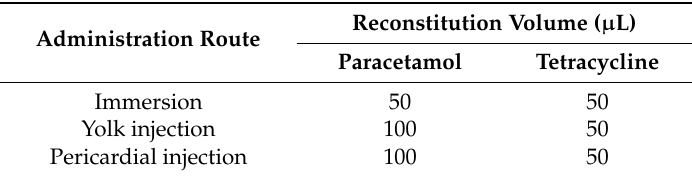
Table 5. Reconstitution volumes for different administration